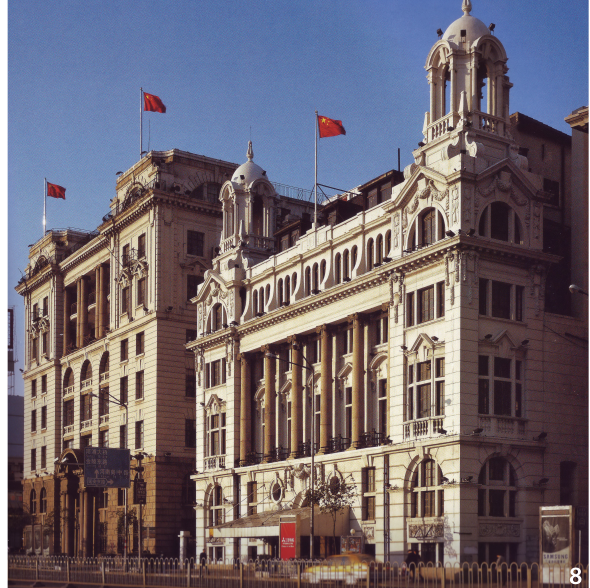
Figure 8 The former Shanghai Club on the Bund after renovation (Source: Institute of Shanghai Architectural Design and Research Co.,